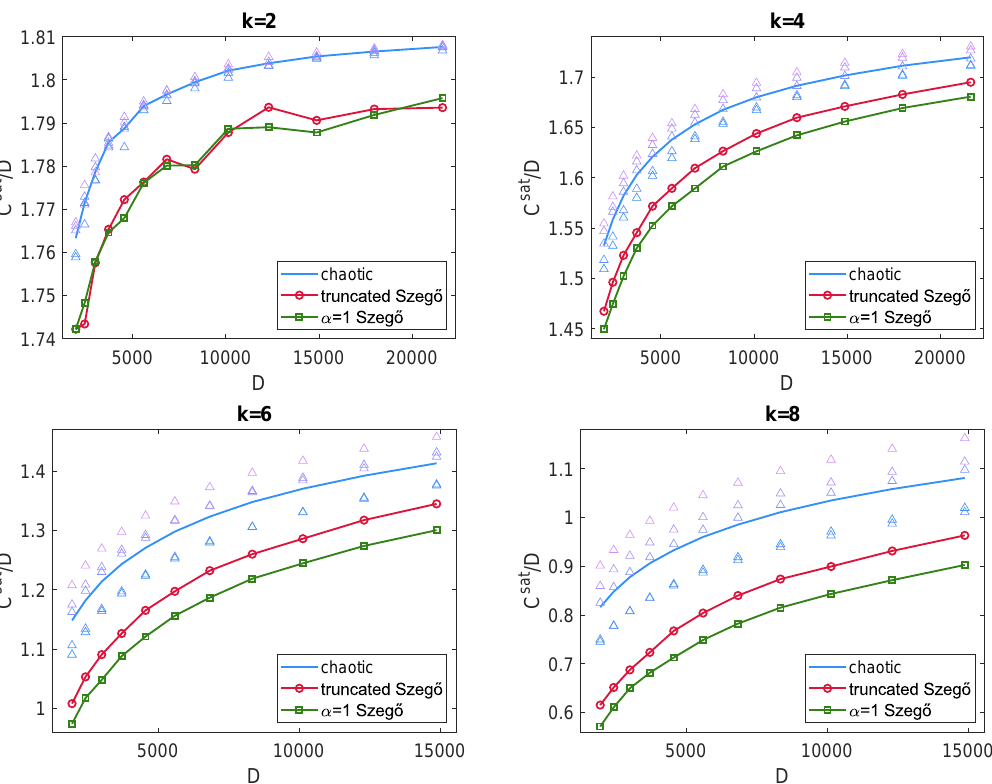
Figure 8: Saturation value of complexity divided by D plotted against D for the blocks N = M = 25,...,37 for k = 2,4 and N = M = 25,...,35 for k = 6,8. The blue line represents the average over five realizations of chaotic Hamiltonians which are denoted by